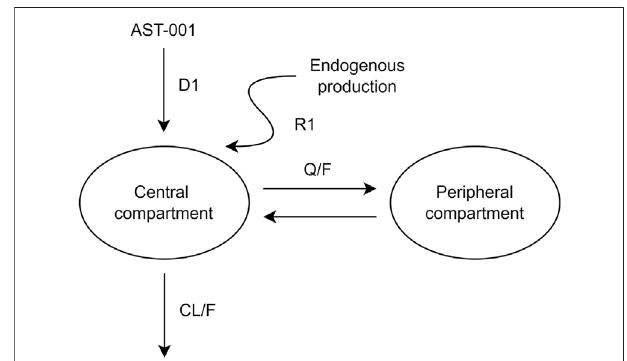
FIGURE 1 | A pharmacokinetic model describing orally administered AST-001 and endogenous production. CL/F, apparent clearance; Q/F, apparent inter-compartmental clearance between the central and peripheral compartments; D1, duration of zero-order absorption; R1, rate of endogenous production of